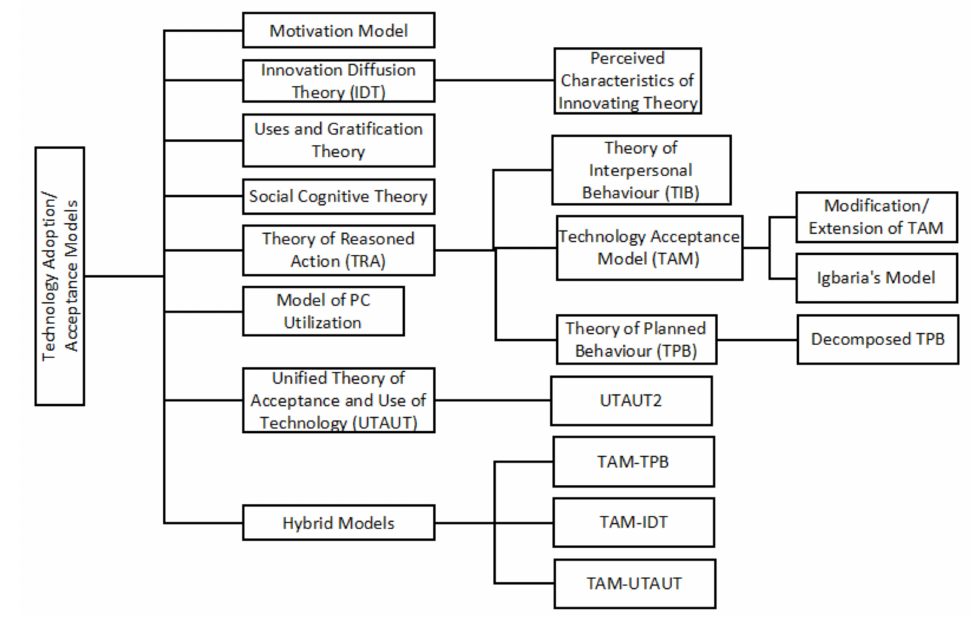
Figure 1. Summary of existing technology adoption